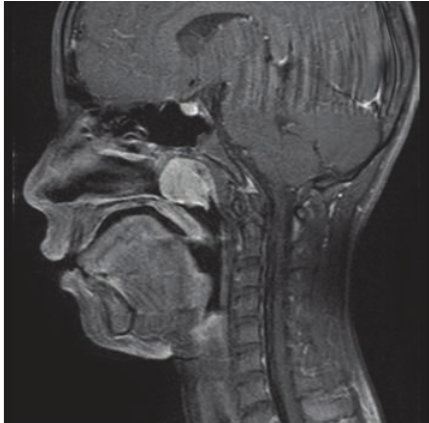
Figure 2: Sagittal T1-weighted magnetic resonance image with gadolinium showing a soft tissue mass with homogeneous enhance-